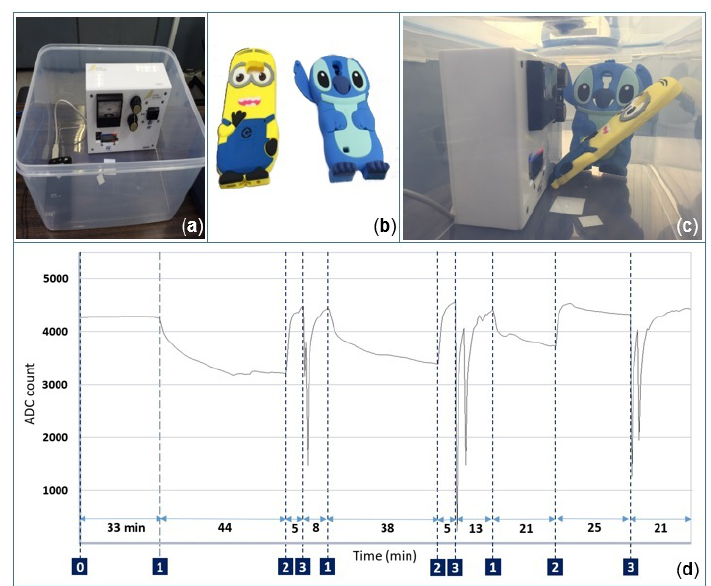
Figure 14. Response of the gas sensor while operating in a closed chamber with and without smartphone covers. ( a ) Two-liter chamber. ( b ) Rubber smartphone cases for Samsung S5 and S6. ( c ) Canary board along with smartphone cases in the same closed chamber. ( d ) Measured resistance of the sensitive layer (not calibrated) during the